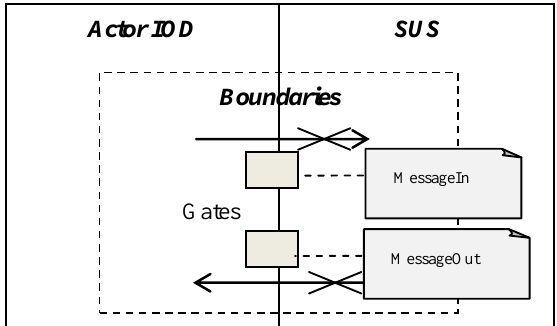
Figure 8. IOD and system boundaries The activity diagram (left side (A)) and its IOD (right side (B)) generated from the use case “ Bob releases a dog ” are given in Figure 9: